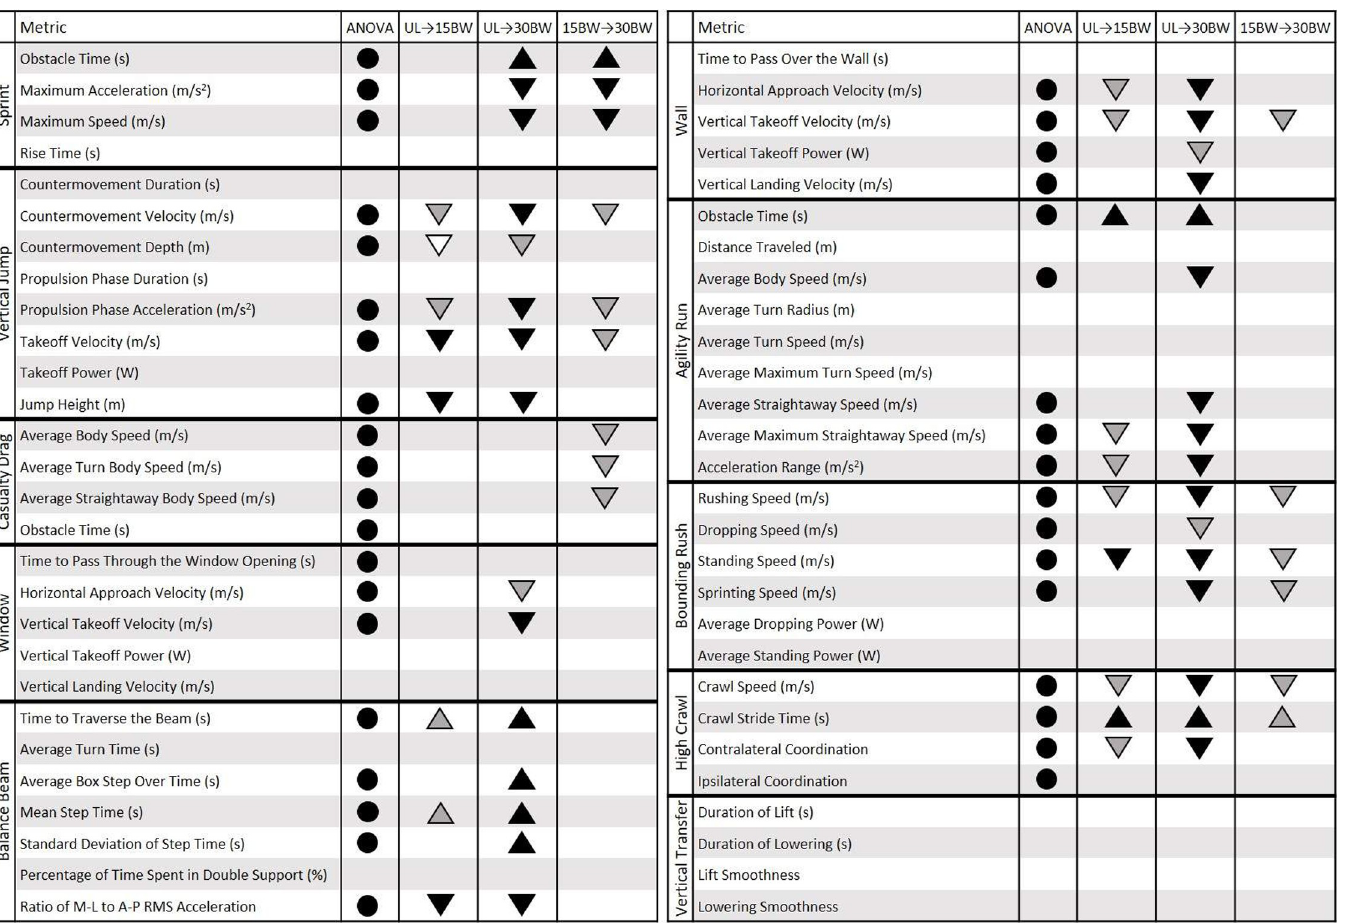
Fig 18. Summary ANOVA and Tukey post hoc results for all performance metrics across all obstacles. The circles under ANOVA indicate metrics exhibiting statistically significant relationships with load. Triangles under the three load comparisons (UL ! 15BW, UL ! 30BW, and 15BW ! 30BW) indicate statistically significant differences between load pairs (Tukey post hoc analysis). The direction of the triangle (up or down) indicates the direction of the change (increase or decrease) in the performance metric (from the first listed loading condition to the second listed loading condition). The gray scale for both symbols (circles and triangles) indicate the effect size defined in Table 2 (white = small effect size, gray = medium effect size, black = large effect size).